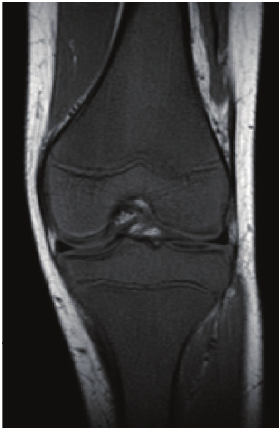
Figure2:MRIfindingsincase2.At4monthsafterthediseaseonset, T1-weighted image depicts low signal intensity in the right femoral and tibial bone marrow.